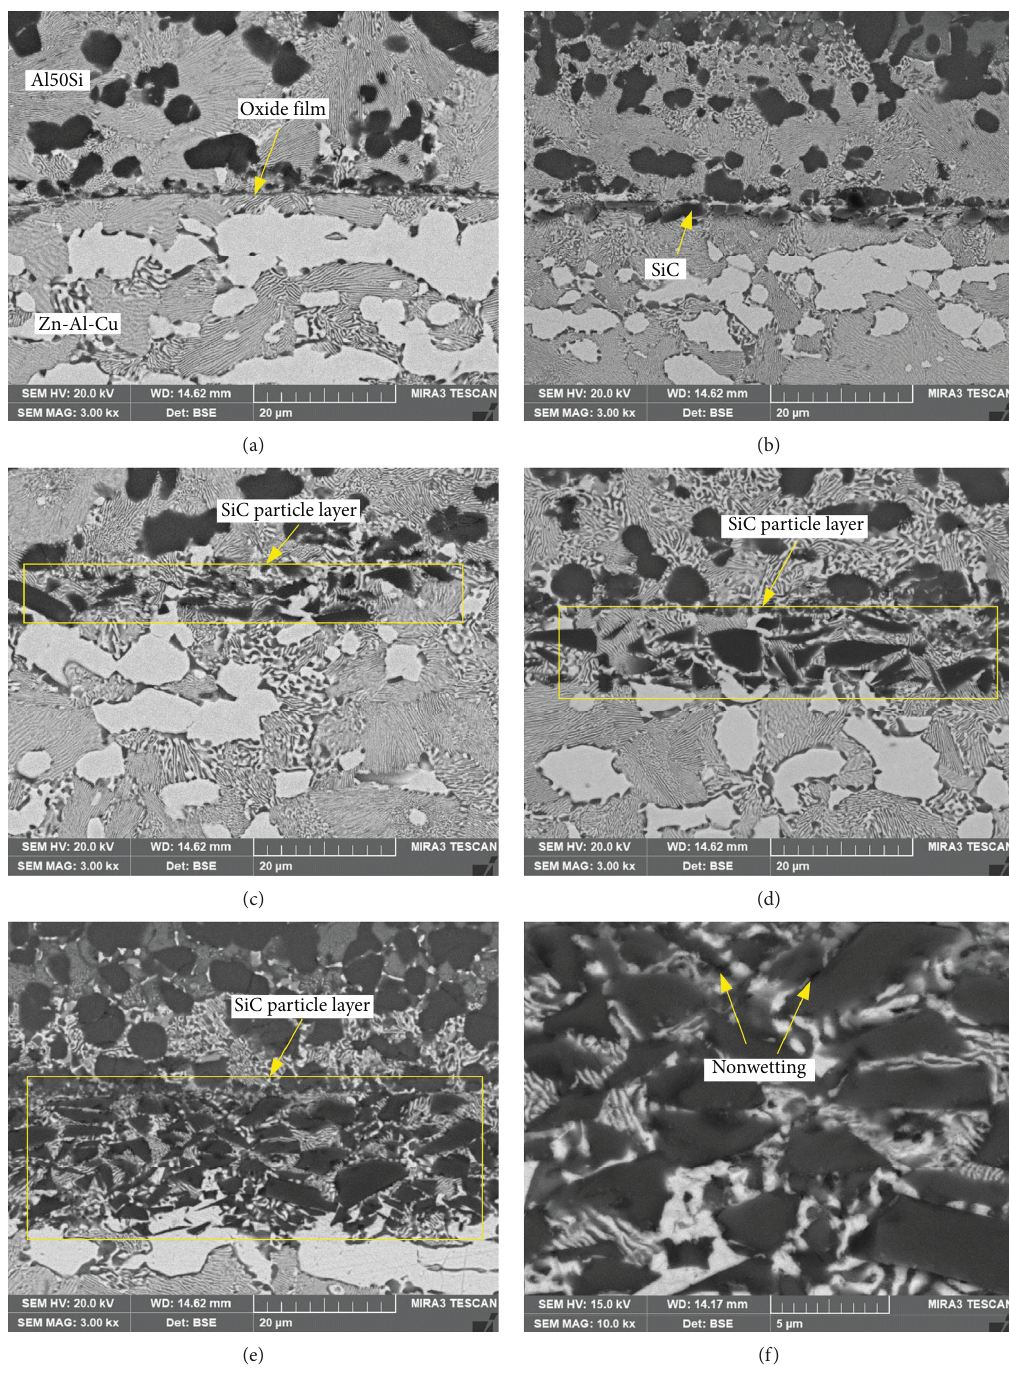
Figure 4: Interfacial microstructure of the joint with 5 μ m SiC particles at (a) 1g/m 2 , (b) 3g/m 2 , (c) 7g/m 2 , (d) 16g/m 2 , and (e) and (f) 32g/m 2